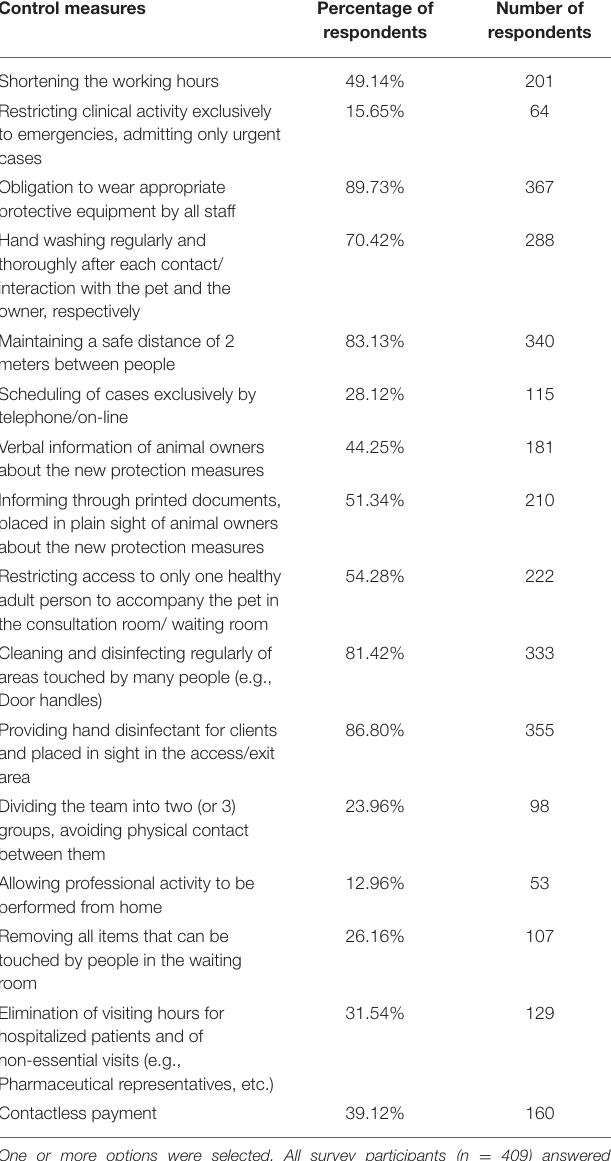
TABLE 1 | Distribution of responses (counts and percentages) of a total number of 409 individuals completing the survey with respect to the control measures implemented at the workplace during the emergency period according to FECAVA and FVE advice leaflet during the COVID-19 outbreak